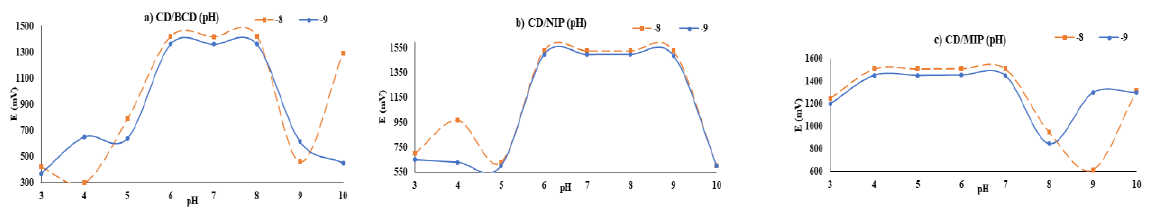
Fig. 7. pH profile of the suggested sensors.